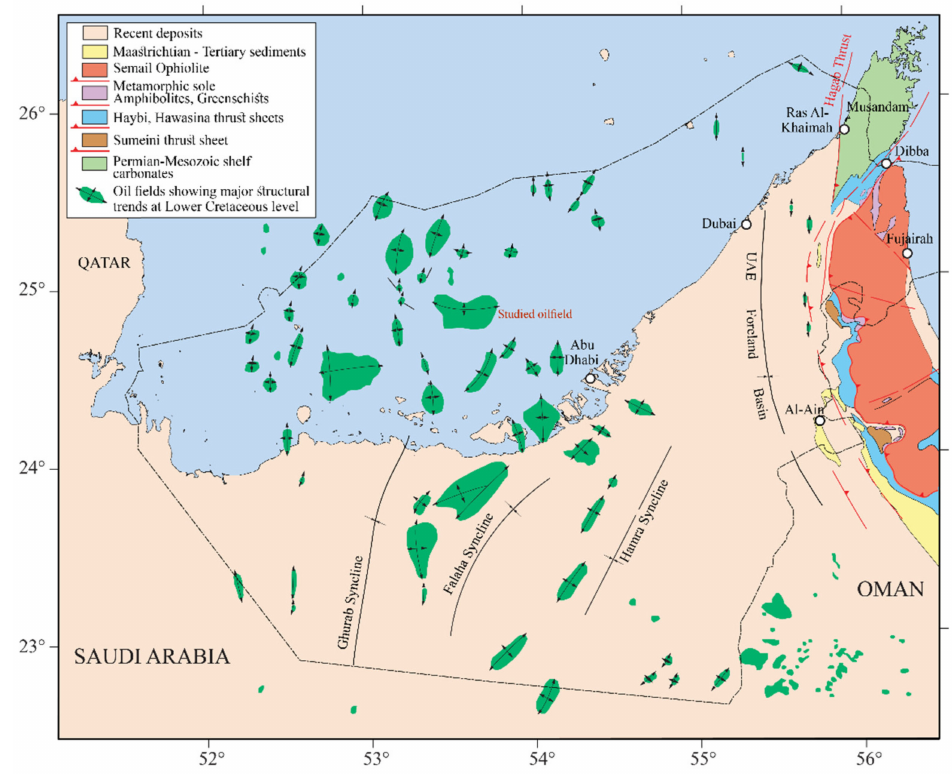
Figure 1. Map of Abu Dhabi oilfields. The oilfield of this study is denoted by nearby red text. A two-component 3D OBC seismic survey was carried out over the oilfield from 2000 to 2001. The full-fold area of the survey was 1505 km 2 . However, in this study we focused on an area of 3 km radius around the wellhead where the 3D VSP survey was acquired (Figure 2). A series of parallel receiver cables were laid down on the seabed with sensor groups at every 50 m. The source lines were orthogonal to the receiver cables at 100 m line spacing and 25 m shot spacing on each line. For each group, hydrophone and